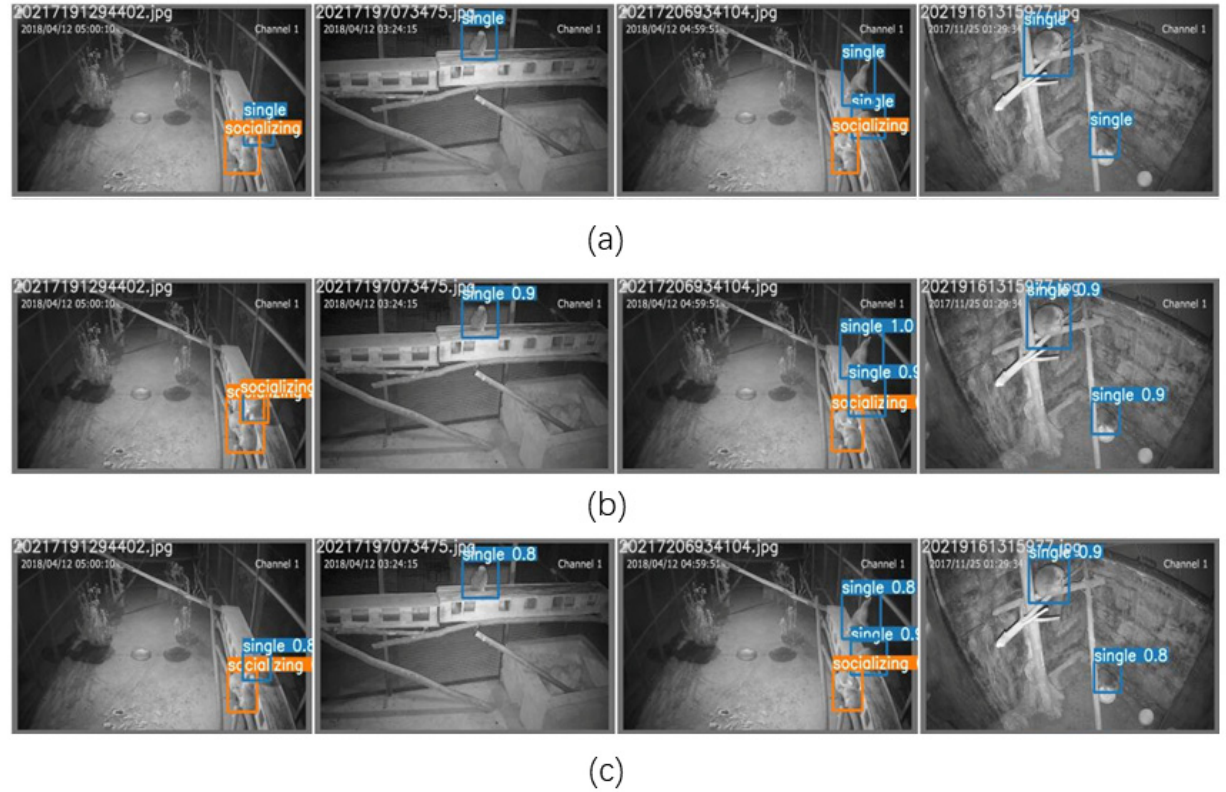
Figure 7. Comparison of YOLOv5-CBAM + TC and YOLOv5 prediction results: ( a ) true labels; ( b ) YOLOv5; ( c ) YOLOv5-CBAM+TC.